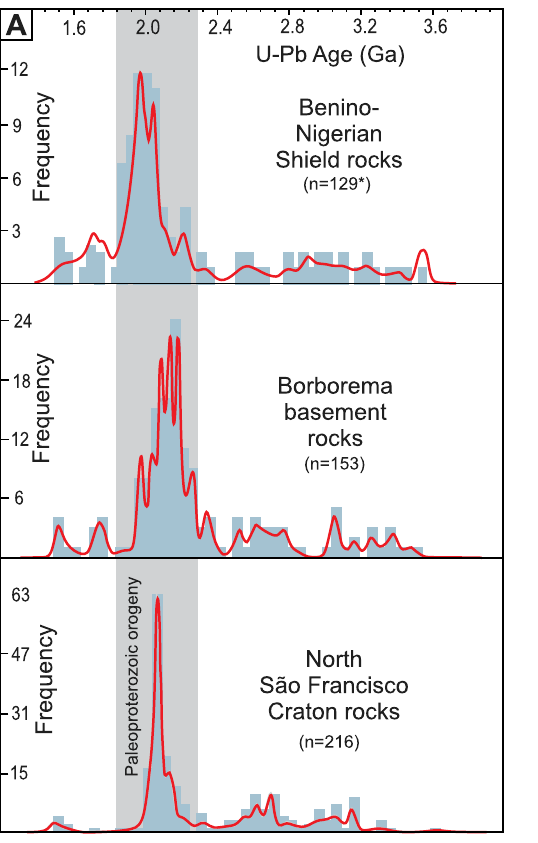
physical image investigation is the link between old Paleoproterozoic and Archean terranes across the province. The Southern Borborema Orogen (Figs. 1A,B, 4), is split into the Sergipano and Riacho do Pontal fold-and-thrust belts by a promontory of the São Francisco Craton, well-defined in the Nd isotopic model age map (Fig. 1B) and geological maps 15,16 . This promontory forms the Entremontes block and may mark an inherited feature of the